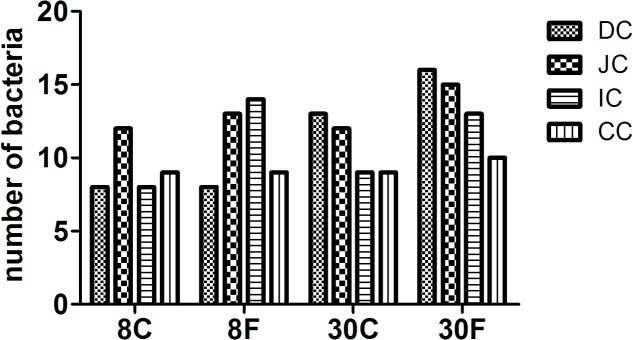
Numbers of bacterial counts in intestinal digesta of hens fed in different patterns. The bar graphic signals were the first character: D for duodenum, J for jejunum, I for ileum, C for cecum, the second character C means contents. 8 and 30 means age of hens, followed C and F presented fed in cage or free range.